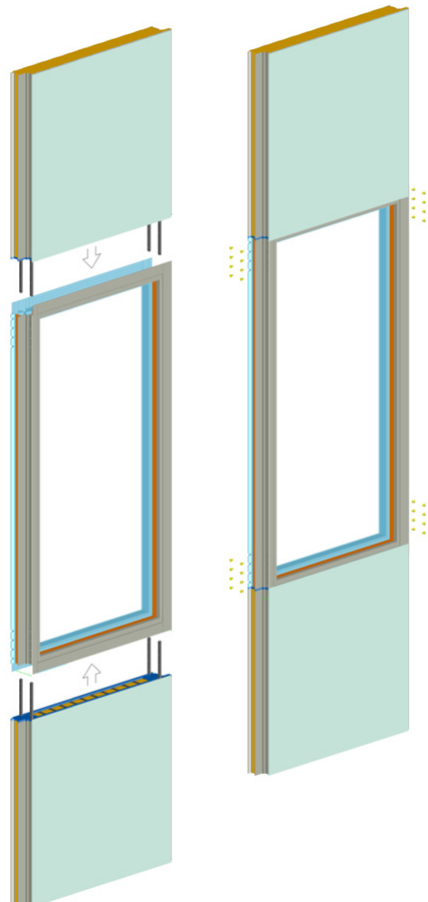
Fig. 12 Assembly of glass sandwich panel with integrated opening and window area (© iconic